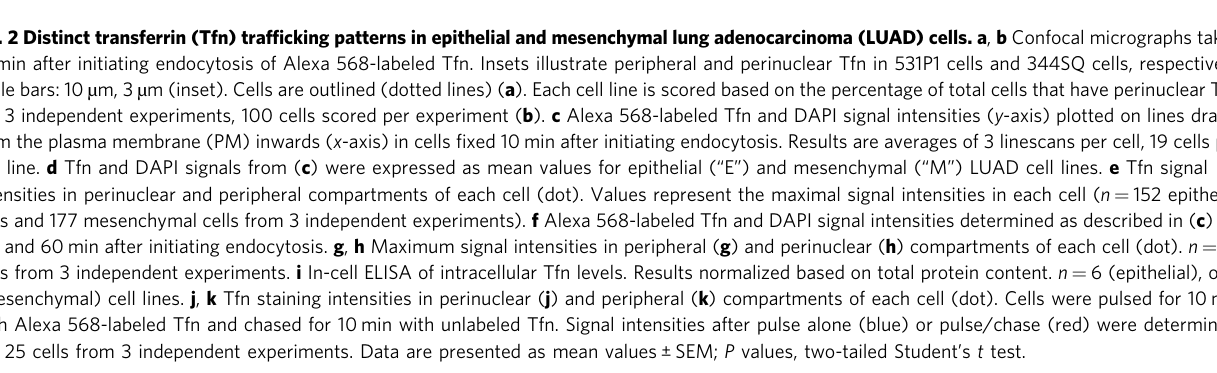
Fig. 2 Distinct transferrin (Tfn) traf fi cking patterns in epithelial and mesenchymal lung adenocarcinoma (LUAD) cells. a , b Confocal micrographs taken 10 min after initiating endocytosis of Alexa 568-labeled Tfn. Insets illustrate peripheral and perinuclear Tfn in 531P1 cells and 344SQ cells, respectively. Scale bars: 10 µ m, 3 µ m (inset). Cells are outlined (dotted lines) ( a ). Each cell line is scored based on the percentage of total cells that have perinuclear Tfn. n = 3 independent experiments, 100 cells scored per experiment ( b ). c Alexa 568-labeled Tfn and DAPI signal intensities ( y -axis) plotted on lines drawn from the plasma membrane (PM) inwards ( x -axis) in cells fi xed 10 min after initiating endocytosis. Results are averages of 3 linescans per cell, 19 cells per cell line. d Tfn and DAPI signals from ( c ) were expressed as mean values for epithelial ( “ E ” ) and mesenchymal ( “ M ” ) LUAD cell lines. e Tfn signal intensities in perinuclear and peripheral compartments of each cell (dot). Values represent the maximal signal intensities in each cell ( n = 152 epithelial cells and 177 mesenchymal cells from 3 independent experiments). f Alexa 568-labeled Tfn and DAPI signal intensities determined as described in ( c ) 10, 30, and 60 min after initiating endocytosis. g , h Maximum signal intensities in peripheral ( g ) and perinuclear ( h ) compartments of each cell (dot). n = 25 cells from 3 independent experiments. i In-cell ELISA of intracellular Tfn levels. Results normalized based on total protein content. n = 6 (epithelial), or 7 (mesenchymal) cell lines. j , k Tfn staining intensities in perinuclear ( j ) and peripheral ( k ) compartments of each cell (dot). Cells were pulsed for 10 min with Alexa 568-labeled Tfn and chased for 10 min with unlabeled Tfn. Signal intensities after pulse alone (blue) or pulse/chase (red) were determined. n = 25 cells from 3 independent experiments. Data are presented as mean values ± SEM; P values, two-tailed Student ’ s t